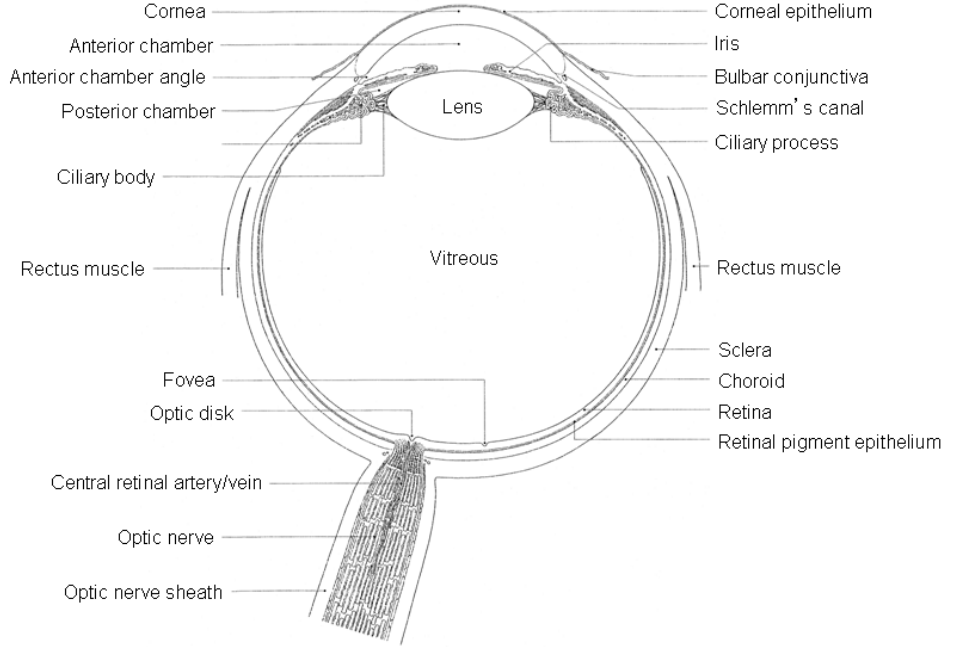
Figure 1. Schematic of the eye-ball